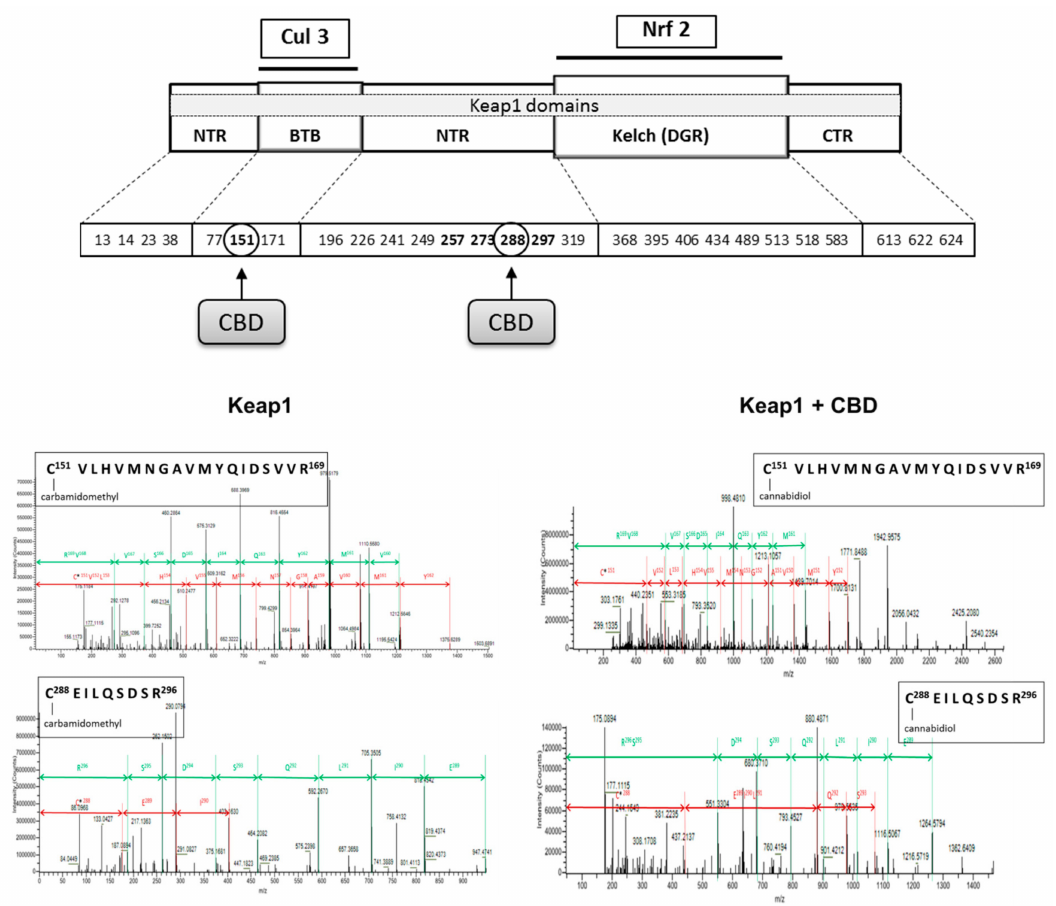
Figure 6. The localization of cysteine residues within Keap1 domains that form adducts with cannabidiol (CBD). Bolded cysteine residues are the most sensitive for